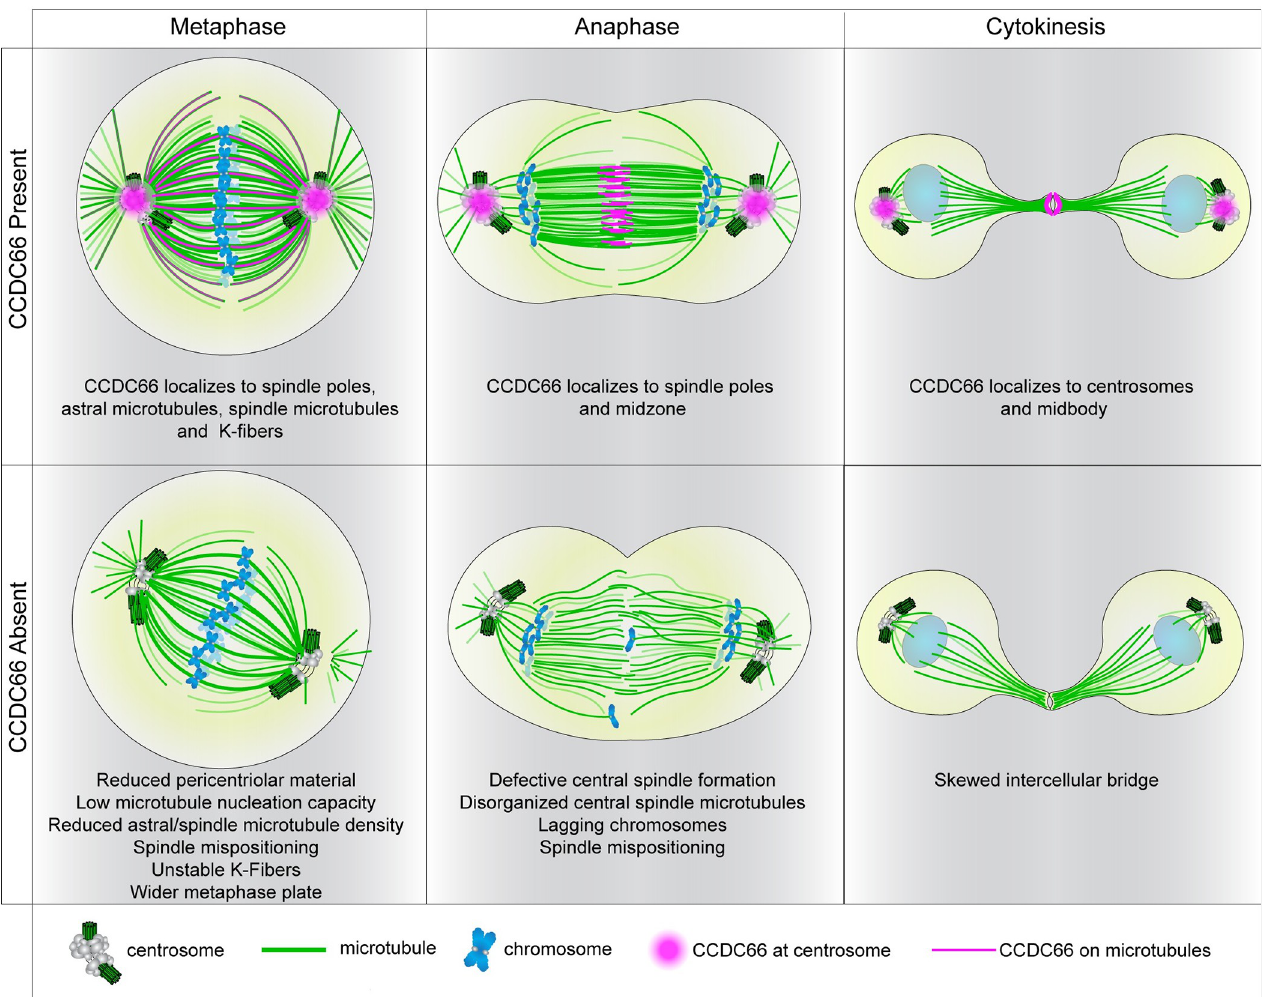
Fig 8. Model CCDC66 localization and functions during mitosis and cytokinesis. AU : AbbreviationlisthasbeencompiledforthoseusedinFig 8 : Pleaseverifythatallentriesarecorrect : The model shows CCDC66 localization during cell division and the phenotypic consequences of CCDC66 depletion on mitotic and cytokinetic MT arrays as well as chromosomes. In metaphase cells, CCDC66 (magenta) localizes to the centrosomes, the astral microtubules, the spindle microtubules, and K-fibers. CCDC66 loss results in a reduced PCM size, microtubule nucleation capacity, astral/spindle microtubule density as well as unstable K-fibers. It also causes a shift in orientation and increases metaphase plate width. During anaphase, CCDC66 localizes to the centrosomes and midzone. CCDC66 depletion causes defective central spindle formation, reduction in central spindle microtubule intensity, lagging chromosomes, and orientation shift. During cytokinesis, CCDC66 additionally localizes to the centrosomes and the midbody. CCDC66 depletion causes asymmetric cleavage furrow formation. CCDC66, coiled-coil domain-containing protein 66; PCM, pericentriolar